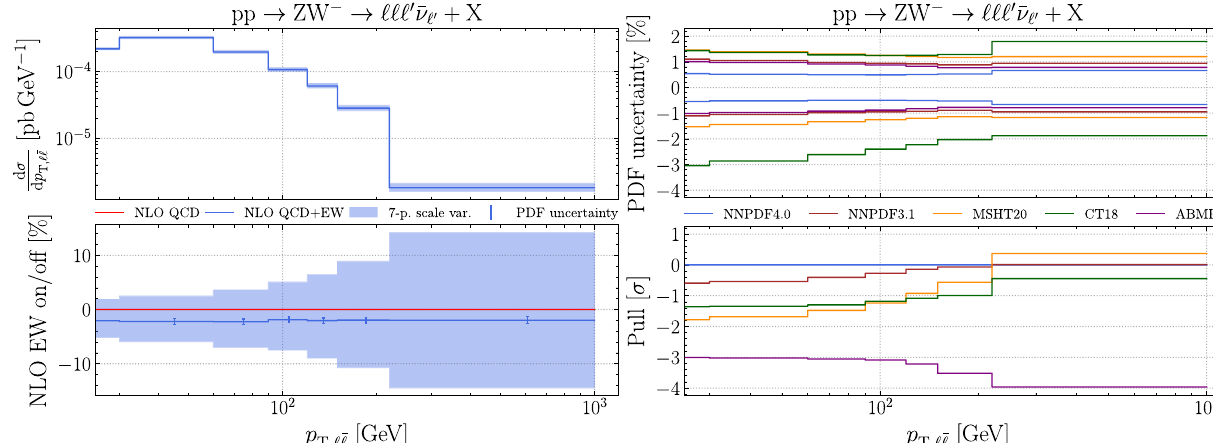
Fig. 66 Same as Fig. 63 for pp → (cid:5) ¯ (cid:5)(cid:5) (cid:8) ¯ ν (cid:5) (cid:8) + X